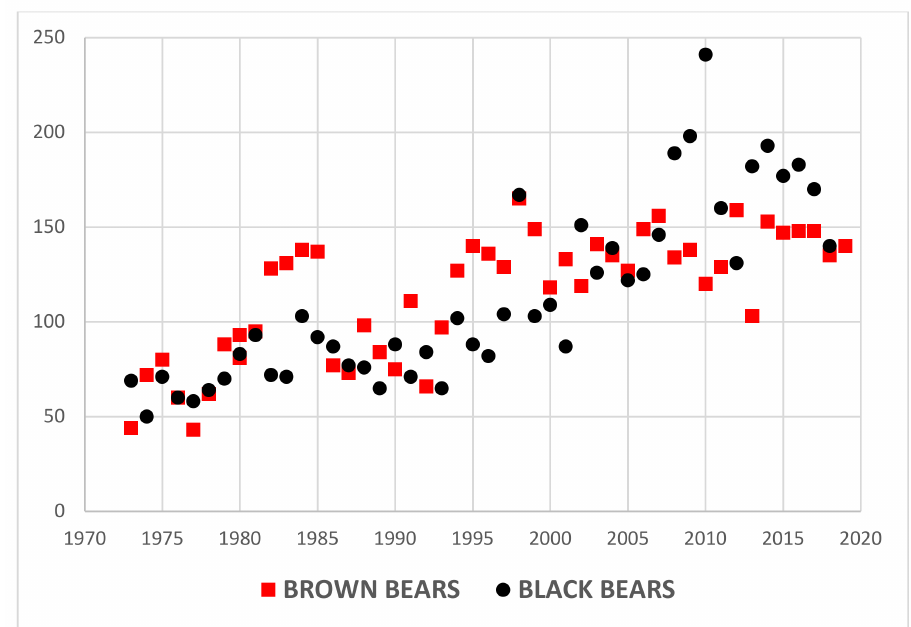
Figure 3. Number of hunter kills of brown bears and black bears in Game Management Unit 13, south-central Alaska, USA,